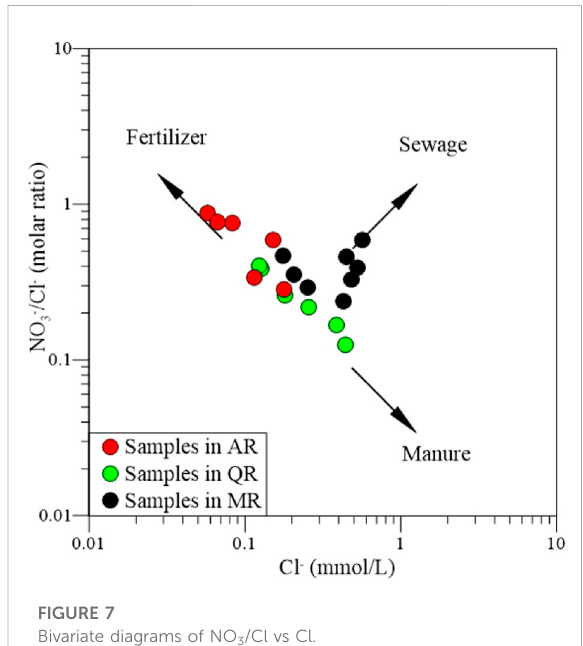
FIGURE 7 Bivariate diagrams of NO 3 /Cl vs